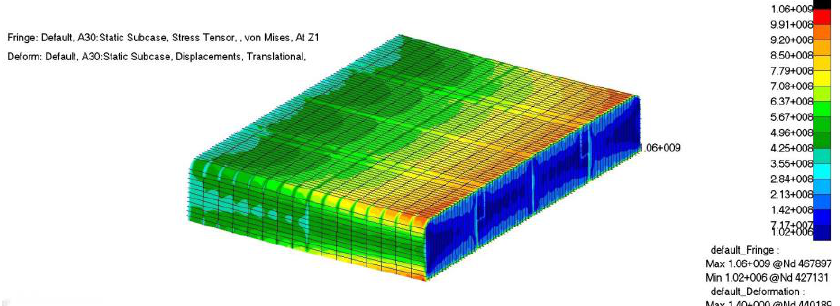
Figure 30 . Stress cloud diagram of the bottom floor of the 4th and 5th cabins at the time of the.